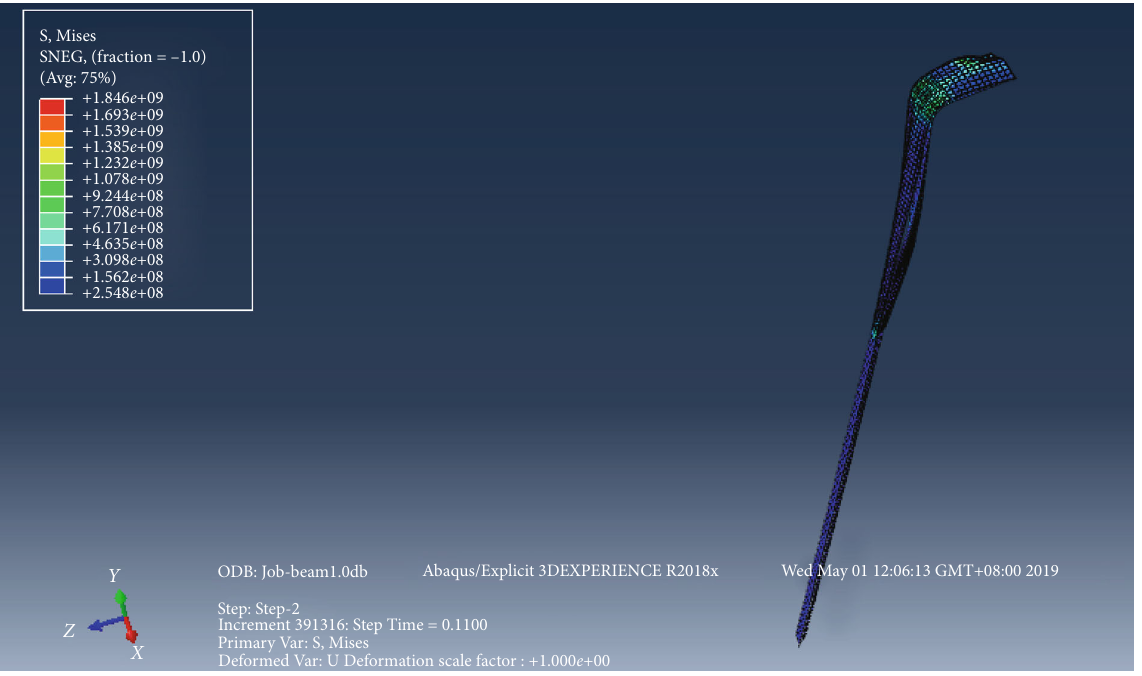
Figure 10: Con fi guration and stress of the folded state.